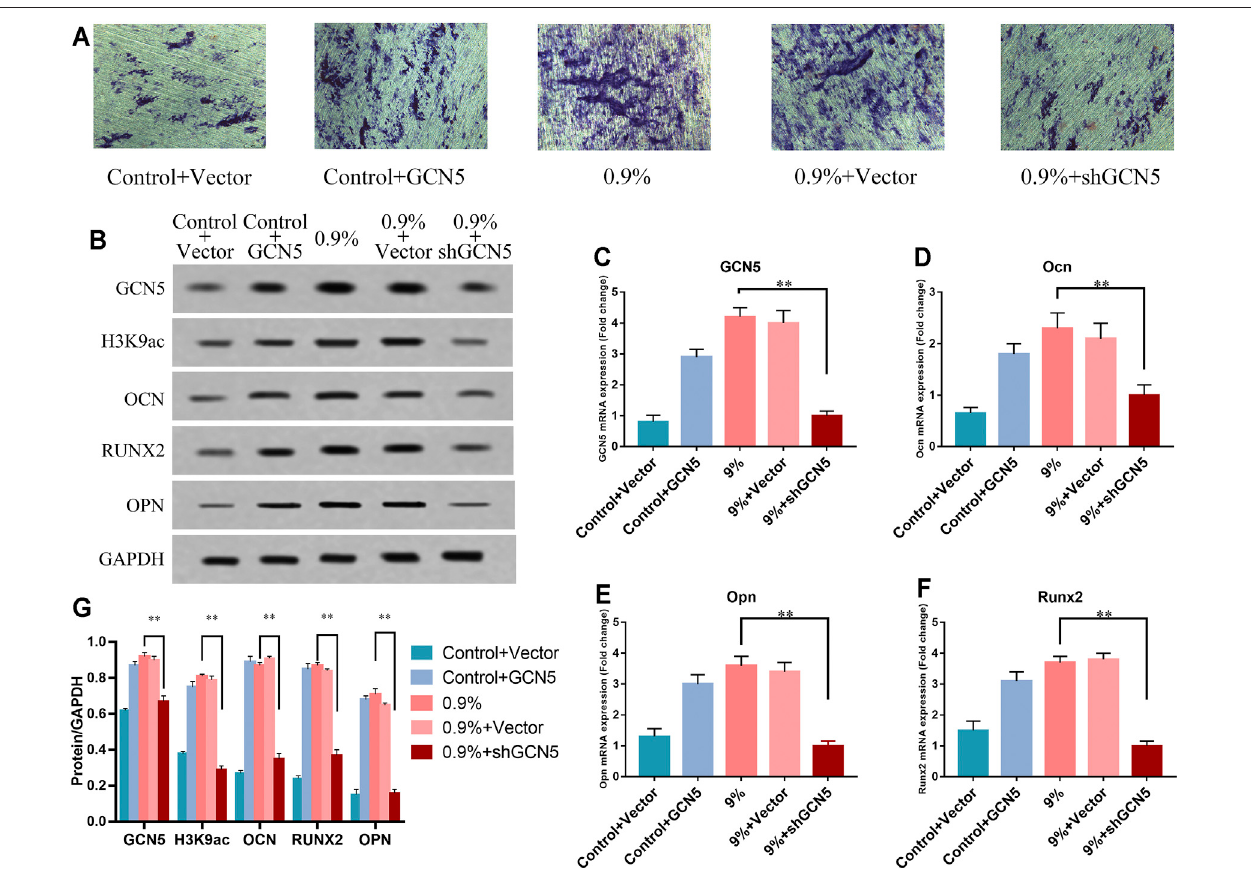
FIGURE 5 | The increased level of GCN5 caused by mechanical strain promoted osteogenic differentiation of BMSCs. (A) ALP activity of BMSCs transfected with overexpression of GCN5 in the control group or shRNA ofGCN5 in the 0.9% group. Scale bars: 500 μ m. (B) Western blots of GCN5, H3K9ac, Ocn, Opn, and Runx2 in BMSCstransfectedwiththeoverexpressionofGCN5inthecontrolgrouporshRNAofGCN5inthe0.9%group.GAPDHisshownastheloadingcontrol. (C) ThemRNA expression of GCN5 veri fi ed gain- and loss-of-function assays promoted by suppressing the expression of GCN5. (D – F) The mRNA expression of Ocn, Opn, and Runx2 in BMSCs transfected with overexpression of GCN5 in the control group or shRNA of GCN5 in the 0.9% group. (G) Semi-quantitative and statistical analyses of the results in Panel B. Values are plotted as mean ± SD, * p < 0.05, ** p < 0.01.